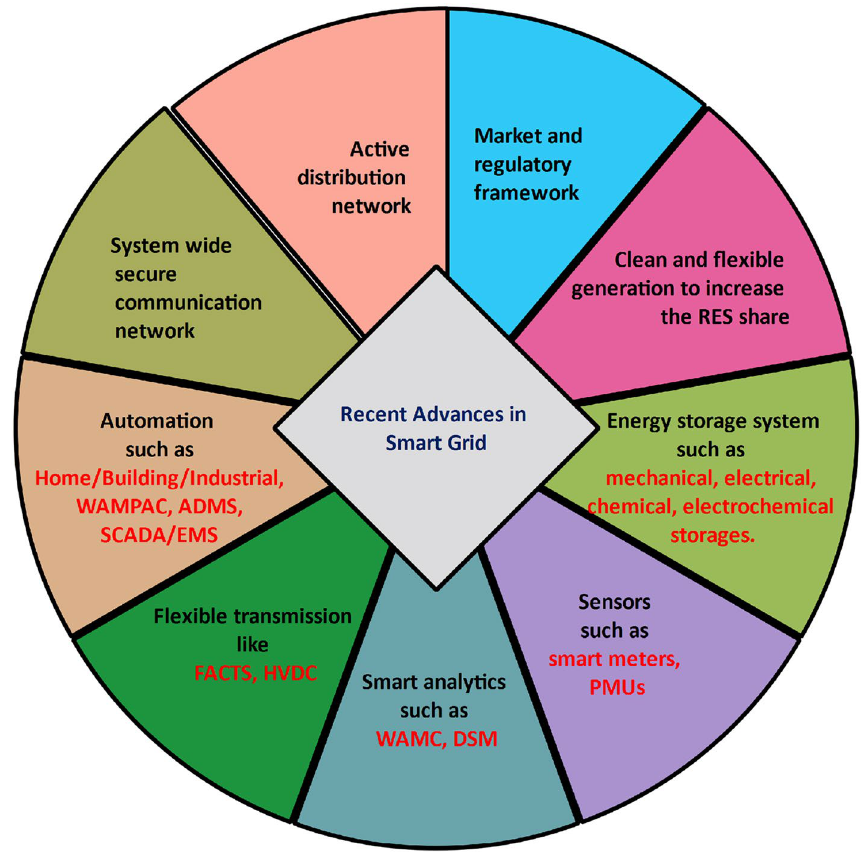
Figure 1. Recent advances in smart